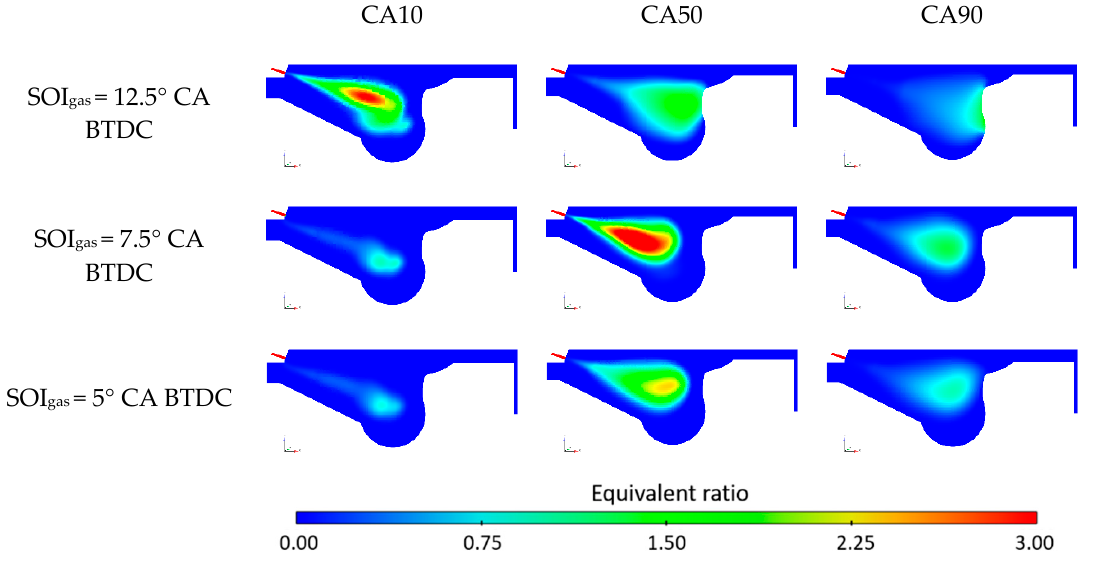
Figure 7. Distribution cloud diagram of local equivalent ratio in the cylinder.